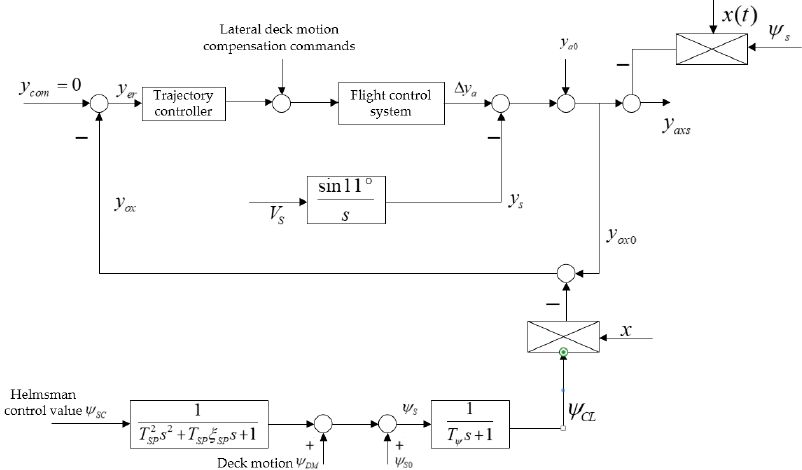
Figure 23. The structure diagram of lateral automatic landing guidance system under deck motion compensation.